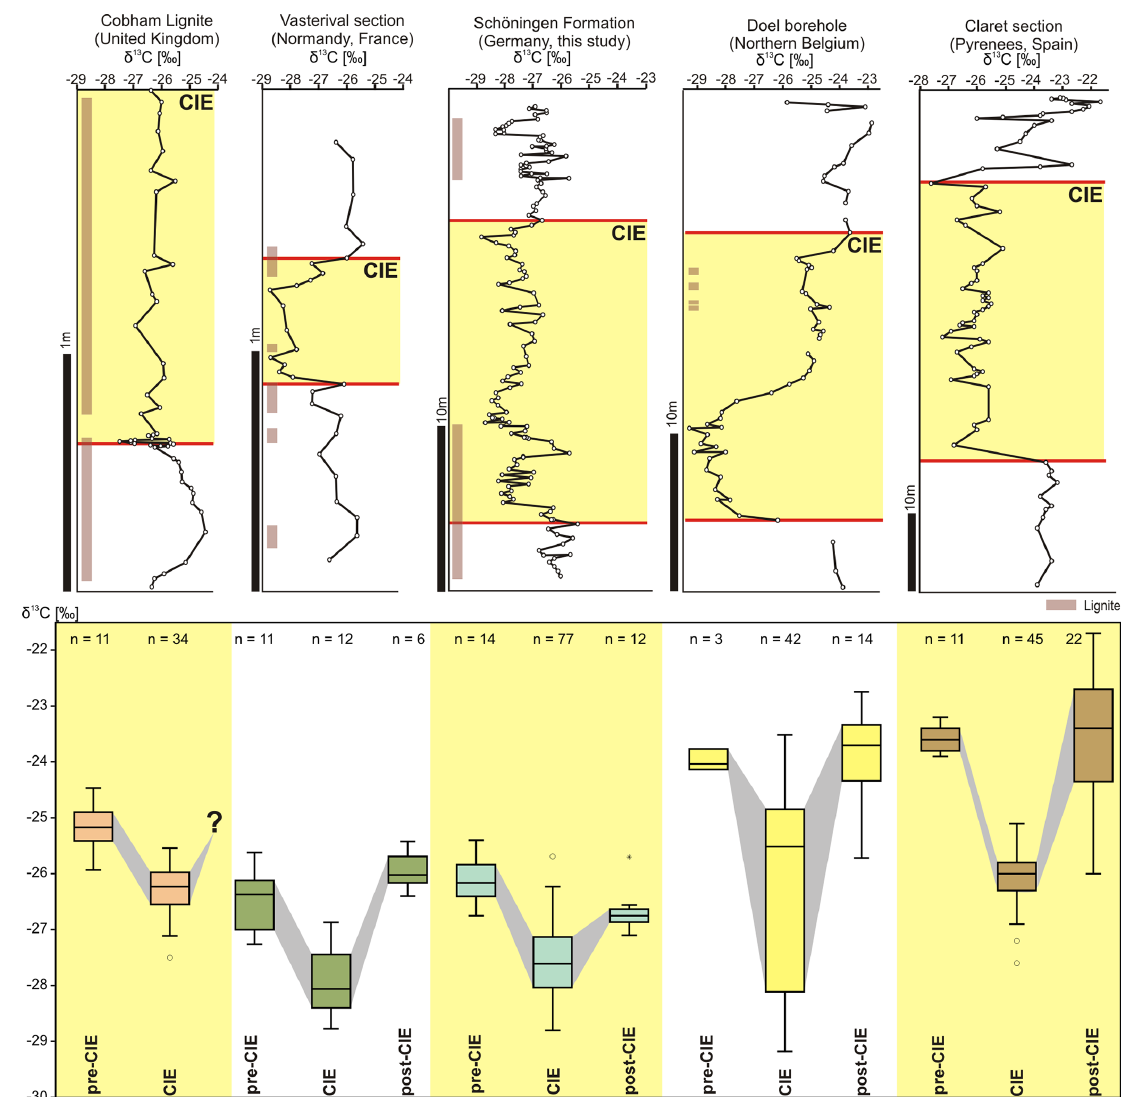
Figure 7. Comparison of mid-latitudinal lignite-related δ 13 C TOC records surrounding the paleo-North Sea: Cobham, UK (Collinson et al., 2003); Vasterival, France (Storme et al., 2012); Schöningen, Germany (this study); Doel borehole, northern Belgium (Steurbaut et al., 2003b). Additionally, a terrestrial δ 13 C TOC record of clastic sediments without lignite from the Pyrenees (Claret section, Domingo et al., 2009) is given that highlights the isotopic differences to the lignite records. Note the different stratigraphic thicknesses due to different sediment accumulation and preservation conditions in the individual depositional environments; n indicates the number of